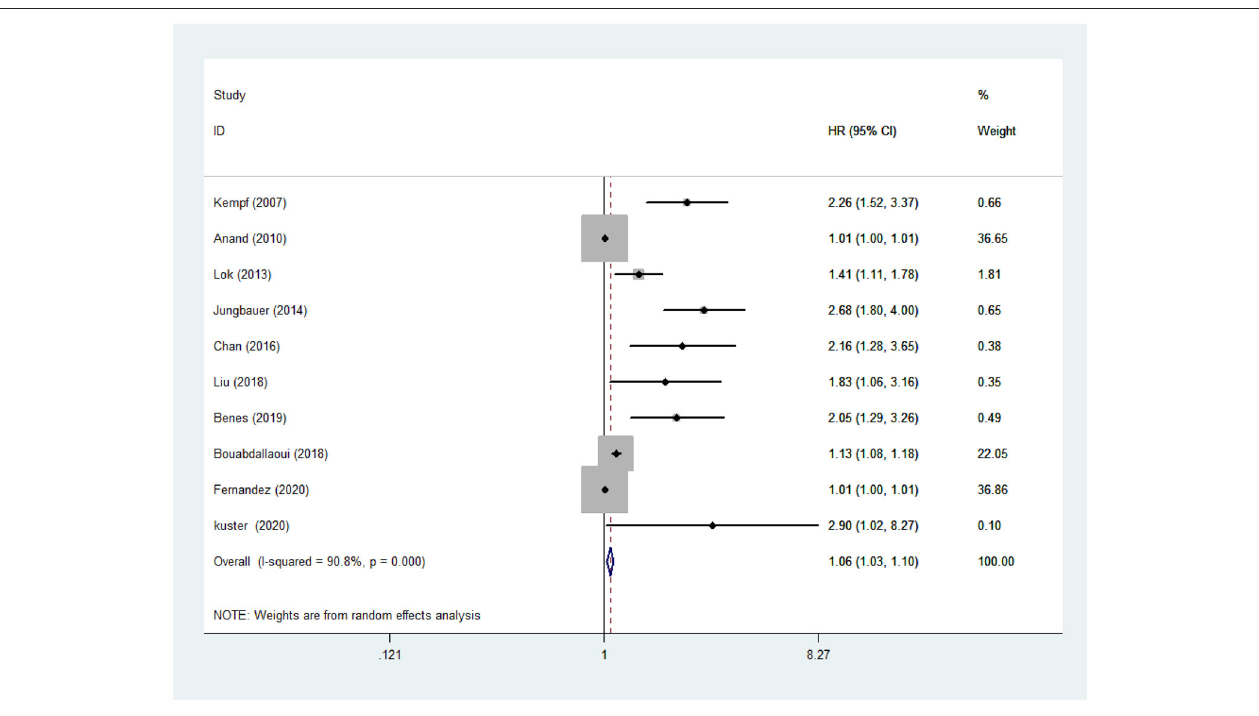
FIGURE 2 | GDF-15 and risk of all-cause death in CHF.